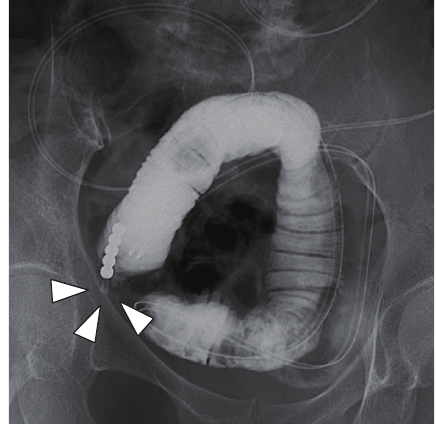
Figure 2: A contrast study showed a focal small bowel obstruction (arrowhead).